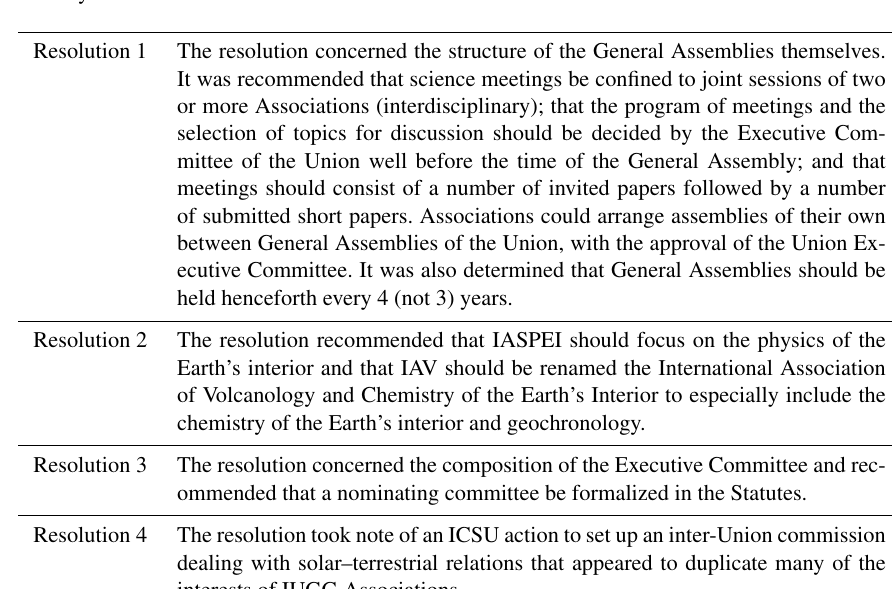
Table 2. Four resolutions by the “Committee of